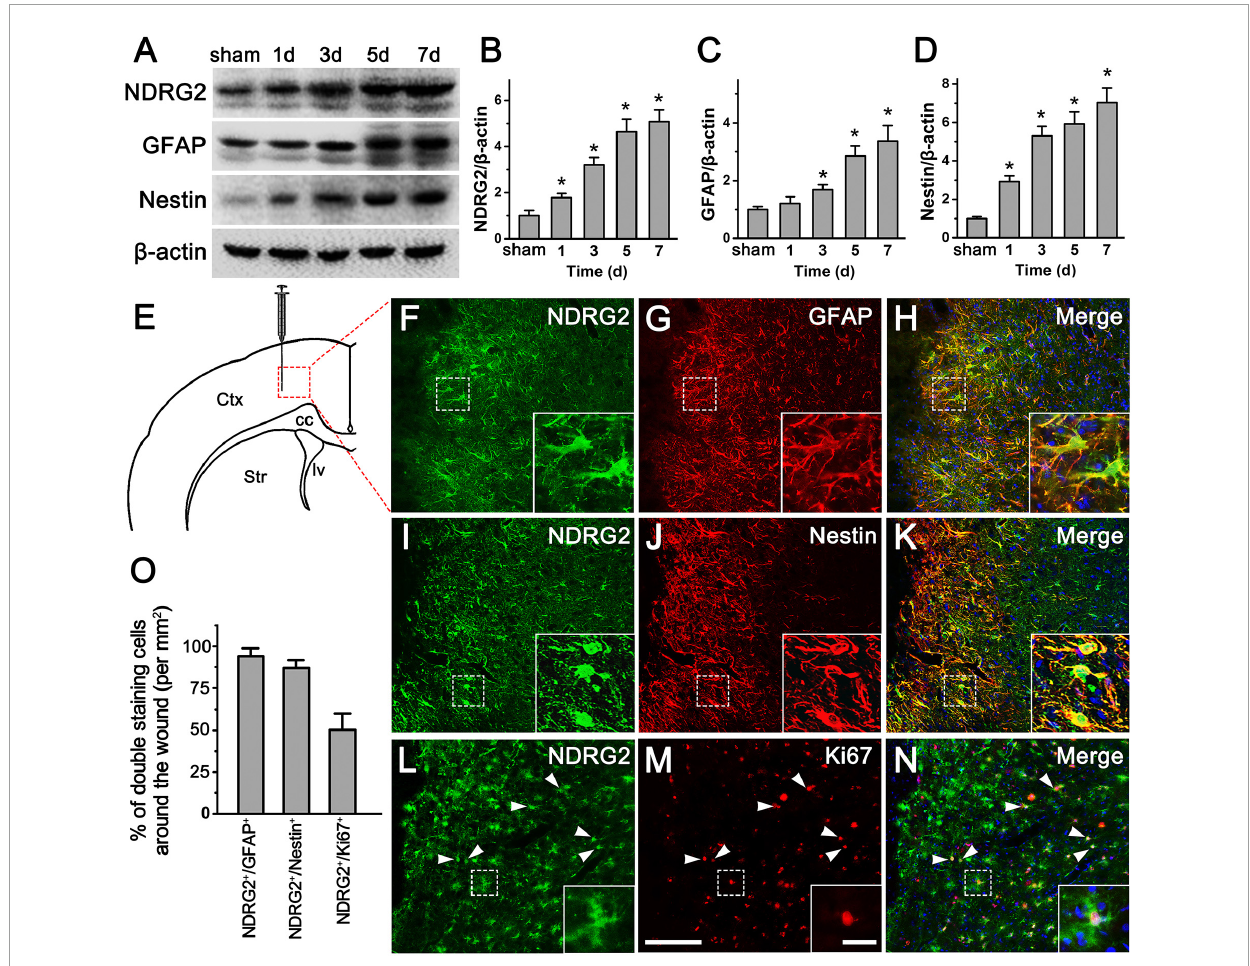
FIGURE2 NDRG2 expression is increased in Rad-PCs after brain stab injury. (A–D) Immunoblotting analysis showed that at 1, 3, 5, and 7 day following stab injury, the levels of NDRG2, GFAP, and Nestin proteins around the wound were gradually increased with time. β -actin was used as an internal control. Quantified data are presented in panels (B–D) . Data are shown as mean ± SEM ( n = 6). * p < 0.05, vs. the sham control. (E) Schematic illustration of brain section from wounded area. Tissue was dissected from the area delineated by the dotted box. Ctx, cortex; cc, corpus callosum; lv, lateral ventricle; Str, striatum. (F–N) At 7 day after stab injury, most of NDRG2-expressive cells (green) were co-labeled with GFAP (red), (F–H) and Nestin (red), (I–K) , and some of NDRG2-positive cells expressed cell proliferative marker Ki67 (red), (L–N) . Cell nuclei were counterstained with Hoechst33342 (blue). Arrowheads show representative NDRG2/Ki67-positive cells. Insets represent the higher magnification of dotted boxes. Scale bar in panel (M) : 100 µ m and in inset: 20 µ m. (O) The percentages of NDRG2 + /GFAP + , NDRG2 + /Nestin + , and NDRG2 + /Ki67 + cells were